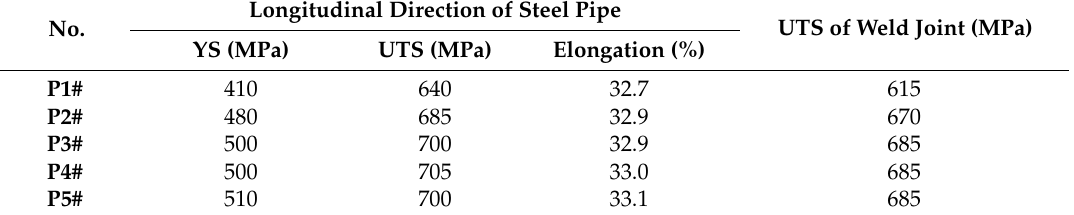
Table 4. Mechanical properties of steel pipe obtained in industrial tests. YS: yield strength; UTS: ultimate tensile strength.